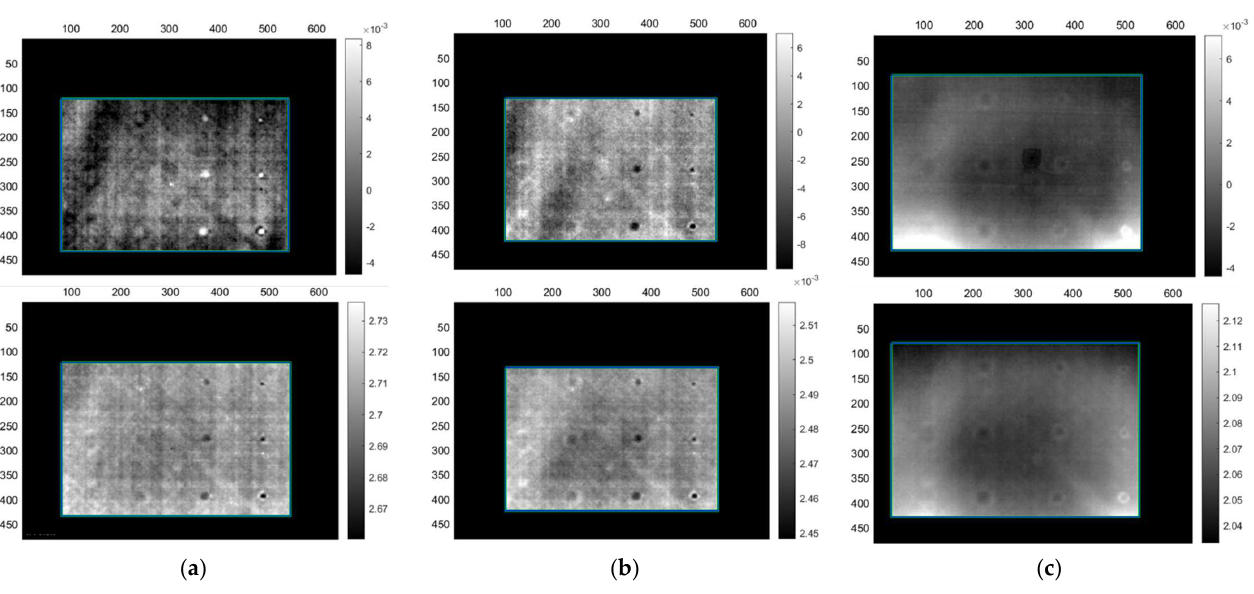
Figure 7. Lock-in thermography PCT ( top ) and FT phase ( bottom ) images from inspection of the monolithic CFRP sample. ( a ) Images from acquisitions LM1, ( b ) LM2 and ( c ) LM3 Table 10. Optical lock-in results from the inspection of the monolithic CFRP sample. Acquisition No.